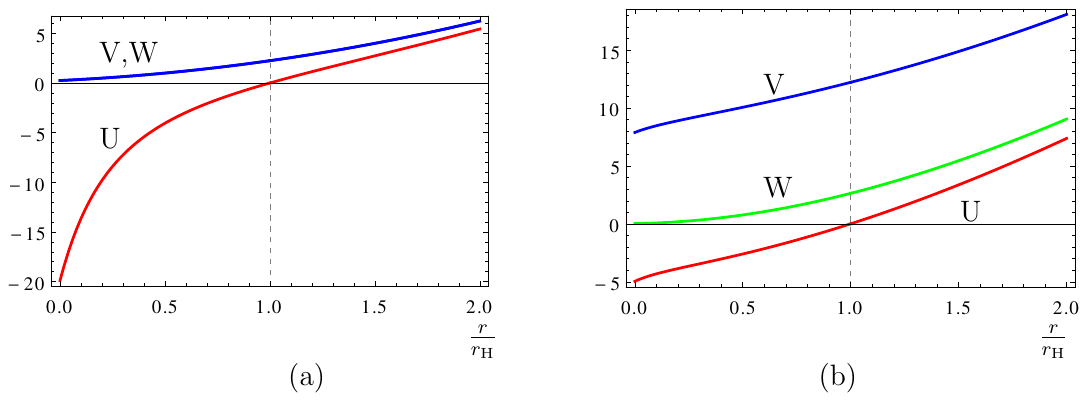
=T 2 = 0. (b) Metric B =T 2 78 : 006. In both cases the dashed B (cid:25)